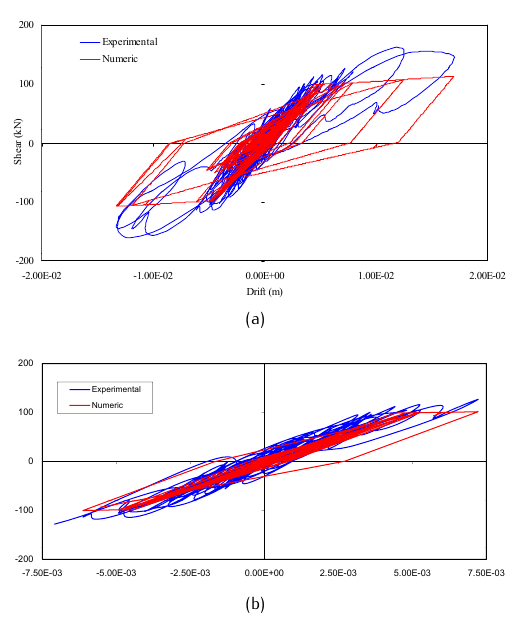
Figure 13. Shear-Top-Displacement, considering only bending beha- vior: (a) complete test; (b) detail.